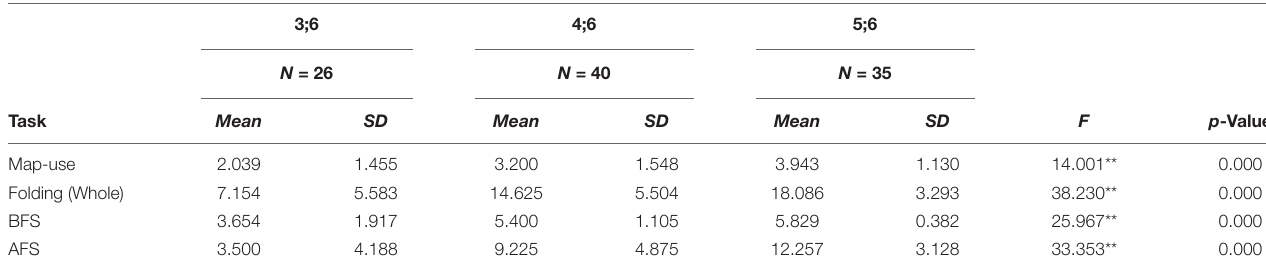
TABLE 2 | Mean, SD, and age difference in the paper folding and map-use tasks.